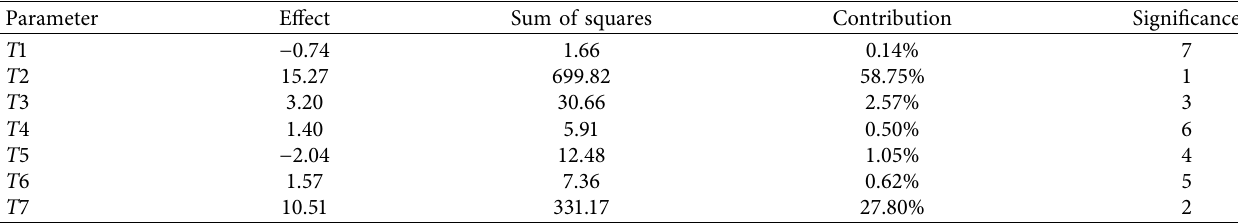
Table 3: Analysis of significance of parameters in PB test.